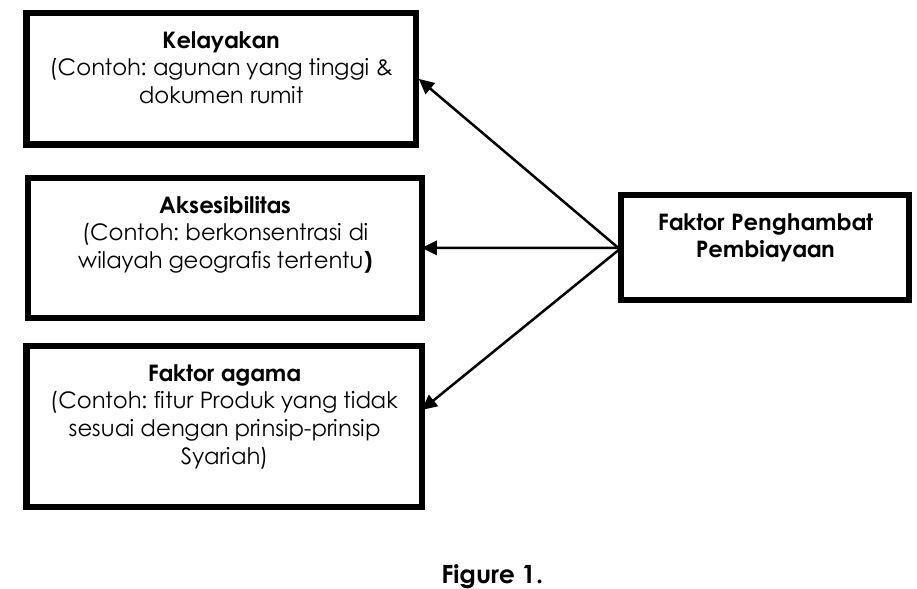
Figure 1. Faktor Penghambat